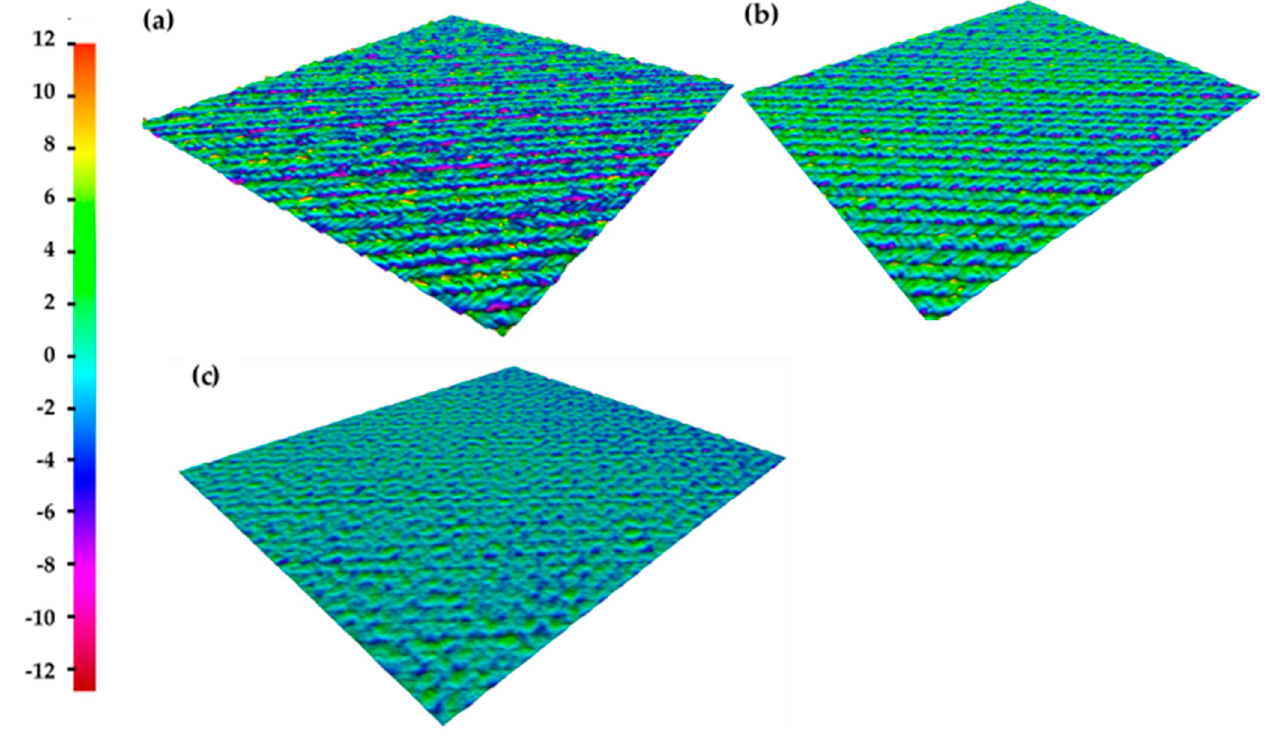
Figure 2. Laser patterned samples: ( a ) sample A, ( b ) sample B and ( c ) sample C. Table 4. Surface roughness parameters of the laser patterns. Laser Pattern Roughness Structure A